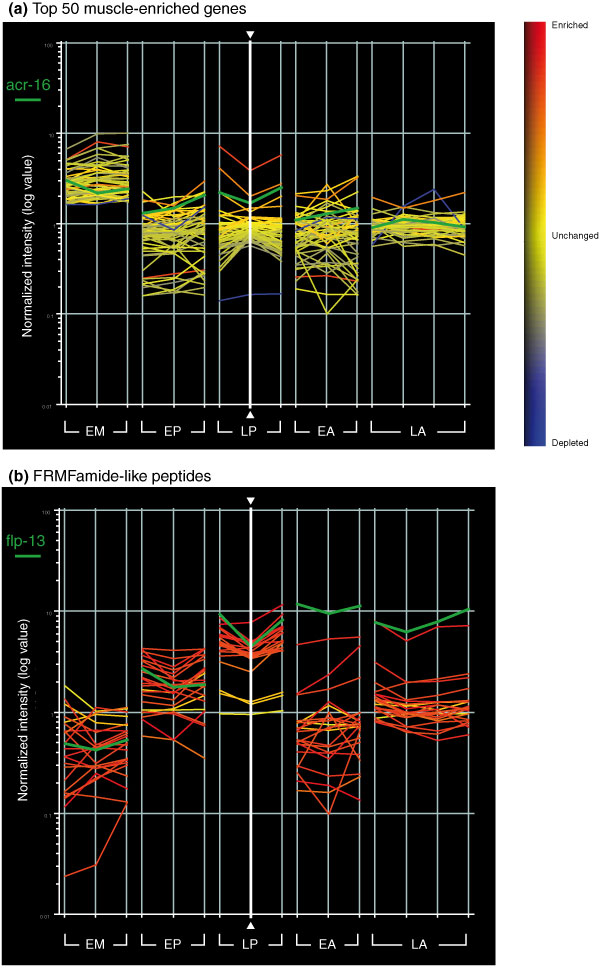
Neuropeptides are highly represented in profiles of neural cells while transcripts highly enriched in body wall muscle are excluded. Line graphs display log base 10 of relative intensity values (experimental/reference) for selected genes on the C. elegans Affymetrix array (see Materials and methods). Vertical lines correspond to individual replicates for each experimental sample. Thus, trends in expression levels for a particular gene or sets of genes can be visualized across all datasets. EM, embryonic muscle; EP, embryonic pan-neural; LP, larval pan-neural; EA, embryonic A-class motor neuron; LA, larval A-class motor neuron. Horizontal lines are colored (see heat map at right) according to relative enrichment of a single LP replicate (vertical white line with arrowheads): enriched (red), blue (depleted) and yellow (no change). (a) The top-50 ranked genes from embryonic muscle show limited enrichment in neuronal datasets. One exception is acr-16, marked by the horizontal green line, which is highly enriched in the LP dataset. acr-16 encodes a nicotinic acetylcholine receptor that is expressed in both muscle cells and neurons [16,17]. (b) FRMFamide-like peptides (flp) are enriched in neurons. A majority (20/23) of the 23 defined flp transcripts is enriched in the LP dataset, whereas specific subsets of flp transcripts are enriched in other neuronal datasets (EP, EA, LA) but largely excluded from the muscle (EM) dataset. The horizontal green highlights flp-13, which is the most highly enriched flp transcript in the A-class motor neuron (EA, LA) datasets.